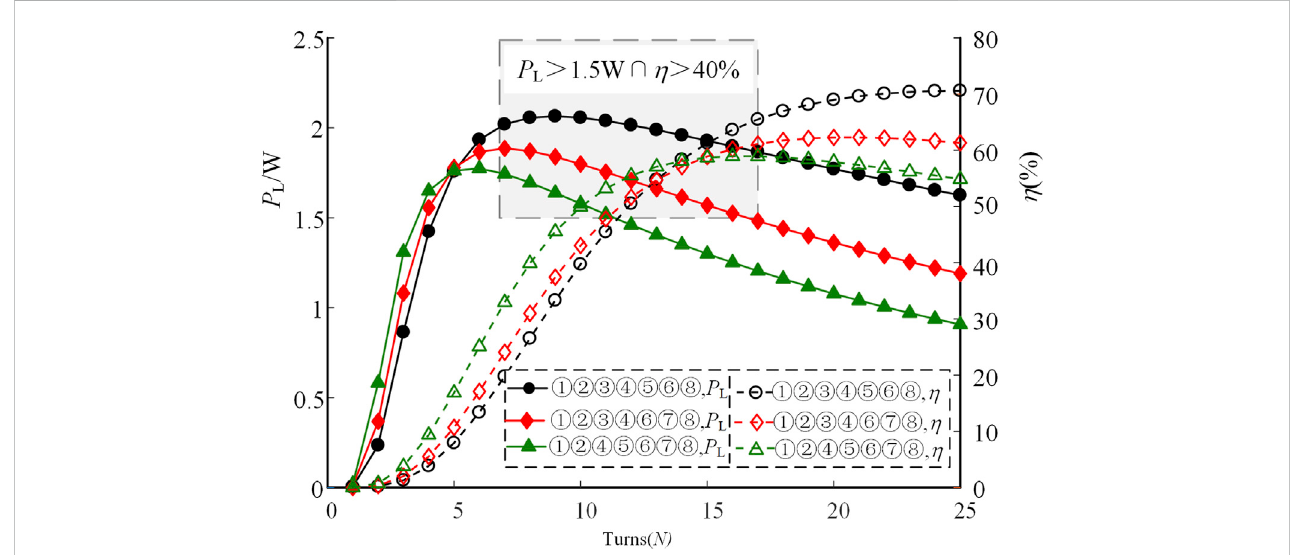
FIGURE 6 The performance of the fi ve-relay coil WPT system varies with N or position.